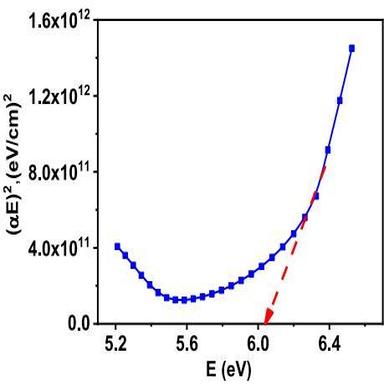
Plot of (αE)2 vs. E of PVA thin film.